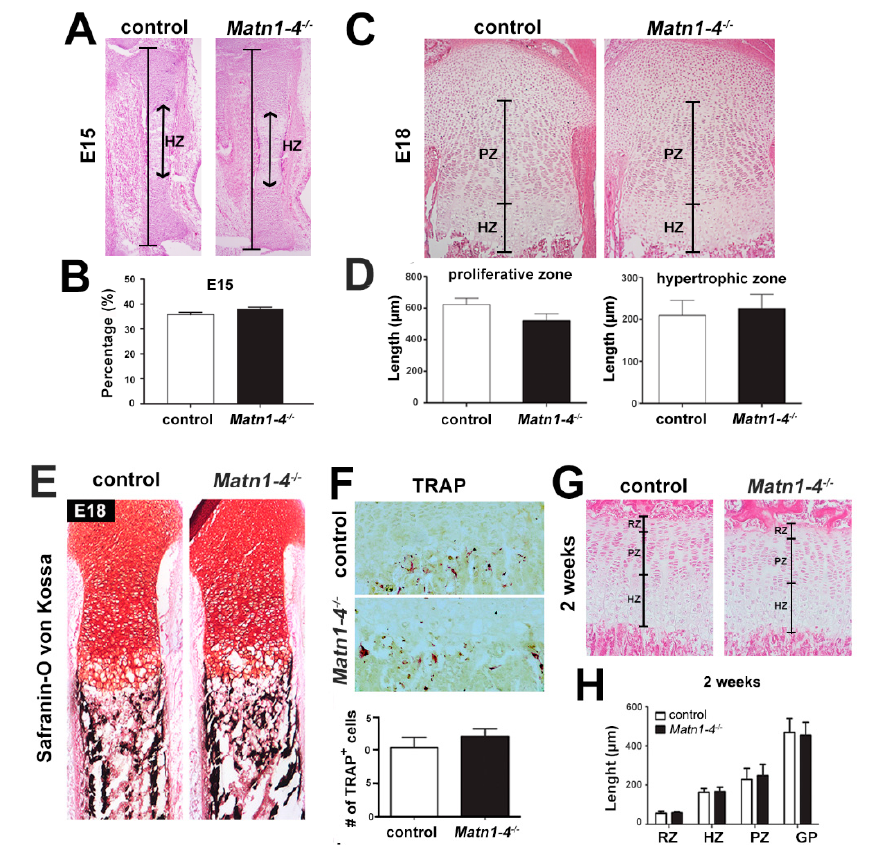
Figure 3. Normal cartilage development and growth plate structure in long bones of Matn1-4 − / − mice. ( A ) HE-stained proximal tibiae at E15.5 show normal length, structure and hypertrophic zone (HZ) in Matn1-4 − / − mice. ( B ) Percentage of the hypertrophic zone relative to the entire cartilaginous mass of the tibia was similar in Matn1-4 − / − and in the control animals. ( C ) HE-stained proximal tibiae at E18 and morphometric measurements of the proliferative (PZ) and hypertrophic (HZ) zones ( D ) demonstrate normal structure of the growth plate in the Matn1-4 − / − mice. Safranin O-von Kossa ( E ) and TRAP staining ( F ) show comparable mineralization and chondroclast / osteoclast activity at the chondro-osseous junction in control and Matn1-4 − / − mice. Quantification of the TRAP positive cells in the tibial growth plate of control and Matn1-4 − / − mice shows no di ff erence at the chondro-osseous junction. ( G ) HE-staining of the tibial growth plate at 2 weeks and morphometric analysis ( H ) of the length of the entire growth plate (GP) and the separated growth plate zones (RZ-resting; PL-proliferative; HZ-hypertrophic) indicate normal columnar organization of the chondrocytes and normal GP zonality in Matn1-4 − / − mice. Original magnifications: × 10 for ( A ), ( C ) and ( E ); × 20 for ( F ) and ( G ).